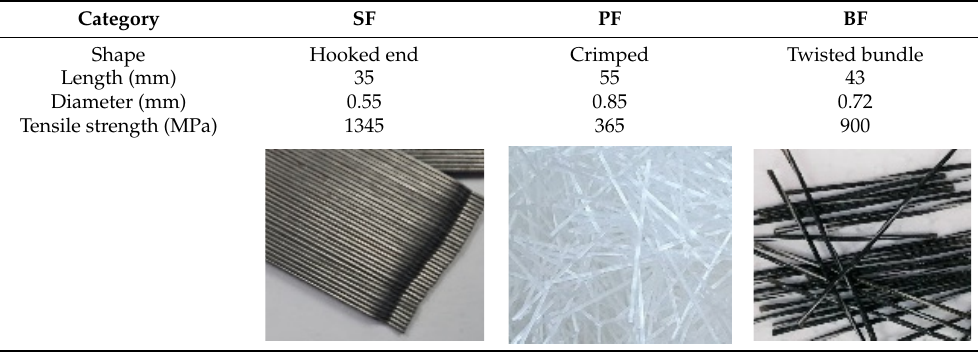
Table 3. Properties of fibers.